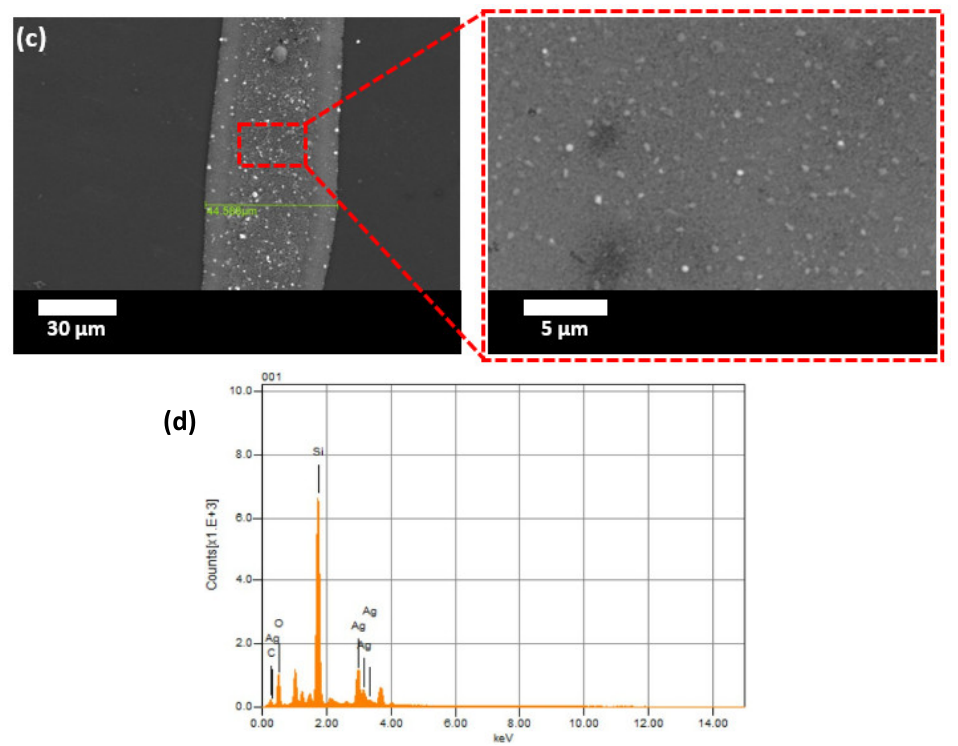
Figure 3. Morphological characterizations of the resistive silver electrodes on the glass substrate. ( a ) Photograph, ( b ) AFM micrograph, ( c ) SEM micrographs, and ( d ) EDX spectrum.